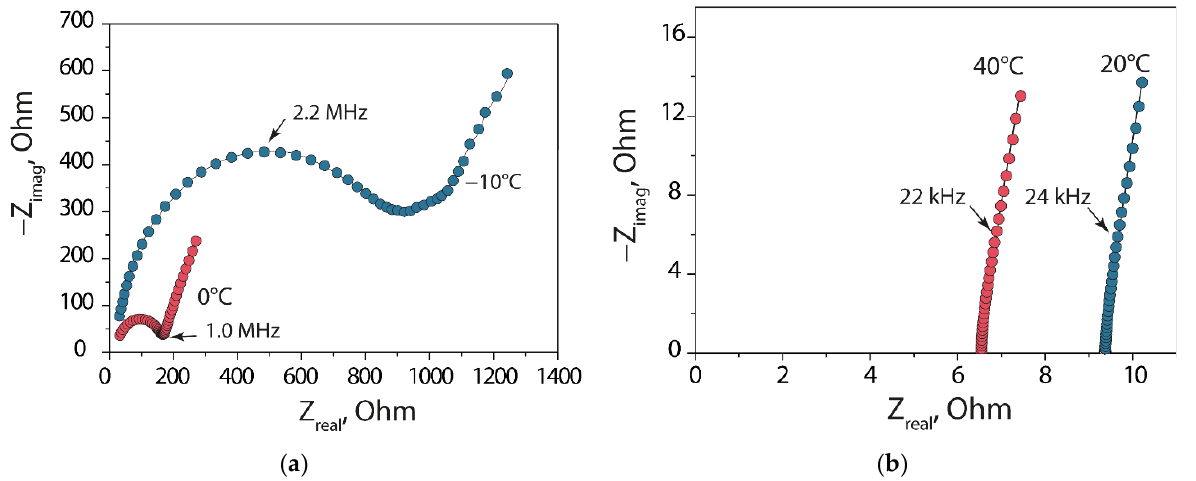
Figure 4. Typical impedance spectra of the Al|SSEBS-Ph-EC-DMA|Al cell at ( a ) low and ( b ) high temperatures .